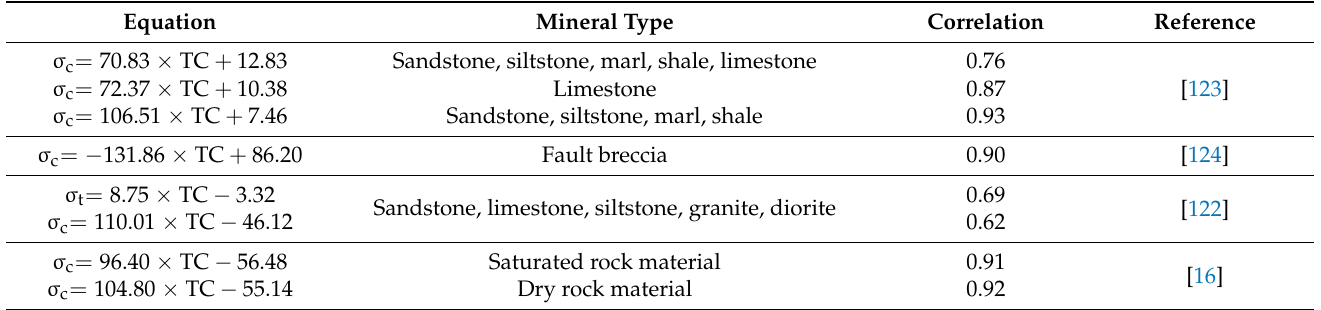
Table 19. Linear empirical equations between UCS and TC ( σ c is uniaxial compressive strength in MPa; σ t is indirect tensile strength in MPa; TC is texture